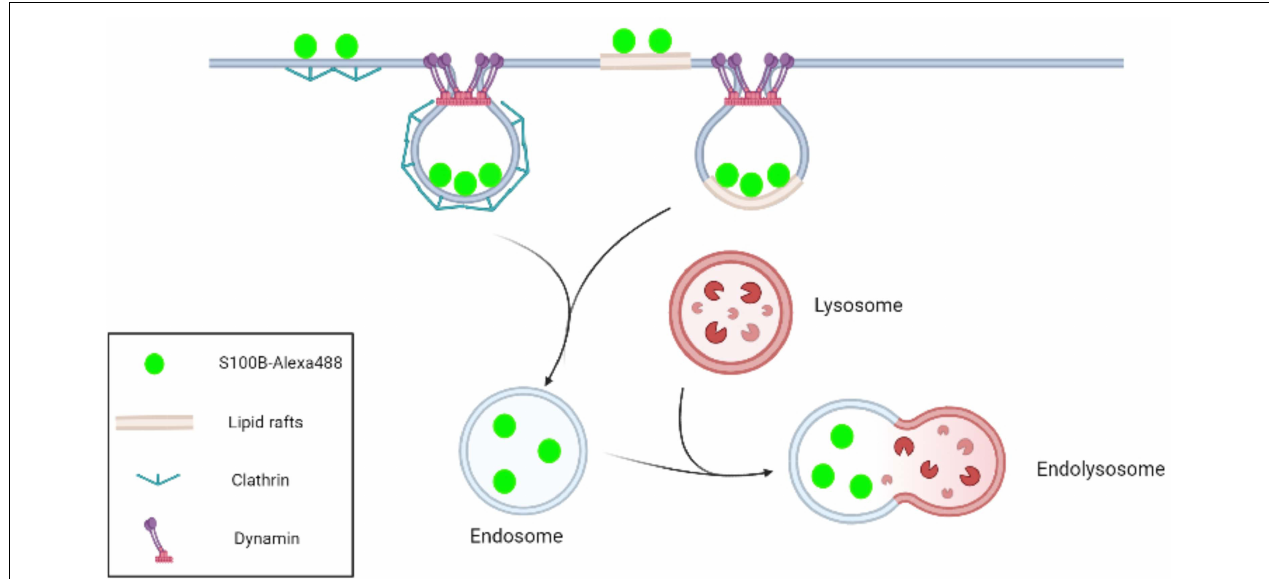
FIGURE 8 | Schematic representation of S100B-Alexa488 internalization by MSCs via the pathways of clathrin- and lipid raft-mediated endocytosis. In the CME process, clathrin-coated pits are initiated by the recruitment of clathrin, and dynamin subsequently acts as a large GTPase to force vesicle scission from the plasma membrane. Lipid rafts are microdomains enriched in cholesterol and sphingolipids. In this work, we observed that S100B-Alexa488 was internalized into the MSC cytoplasm through clathrin- and lipid rafts-mediated endocytosis, and the internalized S100B-Alexa488 may be transported through endolysosomal pathways.